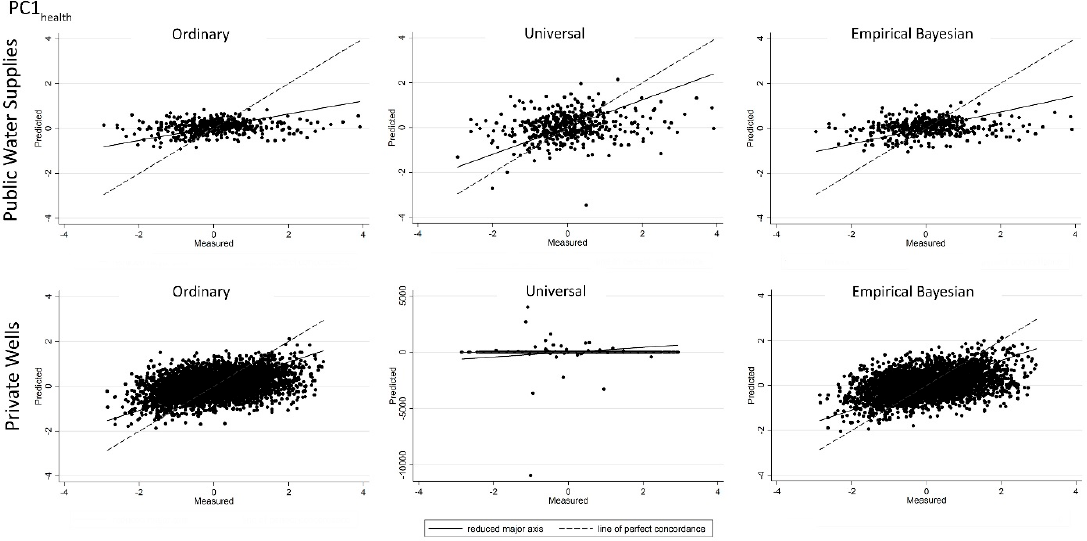
Figure A2. Predicted vs. measured values for PC1 health scores obtained from the cross-validation results for ordinary, universal, and empirical Bayesian kriging for: public water supplies ( top row ); and private wells ( bottom row ). Line of perfect concordance indicated by dashed line.